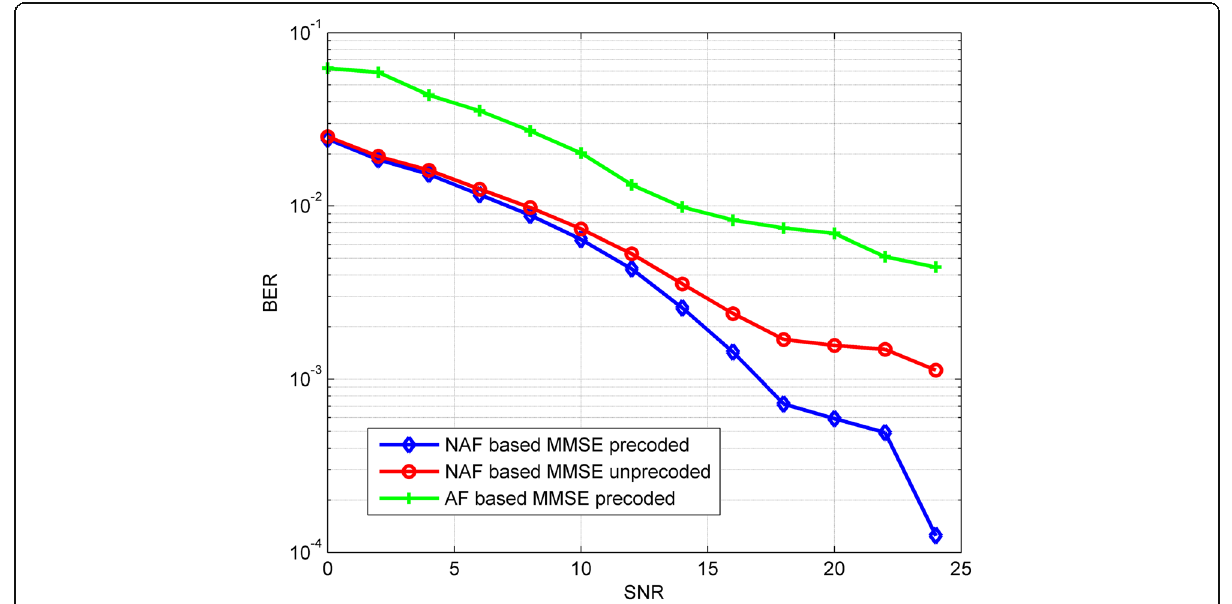
Fig. 2 The performance comparison of NAF with MMSE unprecoded/precoded and AF precoded MMSE in MIMO relaying systems